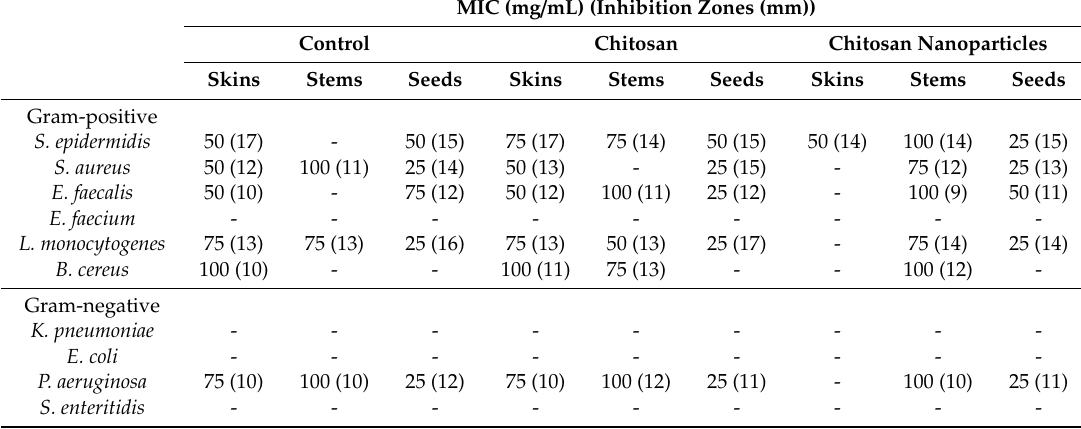
Table 4. Minimum inhibitory concentration (MIC) and the inhibition zones (mm) of grape skins, stems and seeds of Sous ã o variety with no treatment (control), treated with chitosan and with chitosan